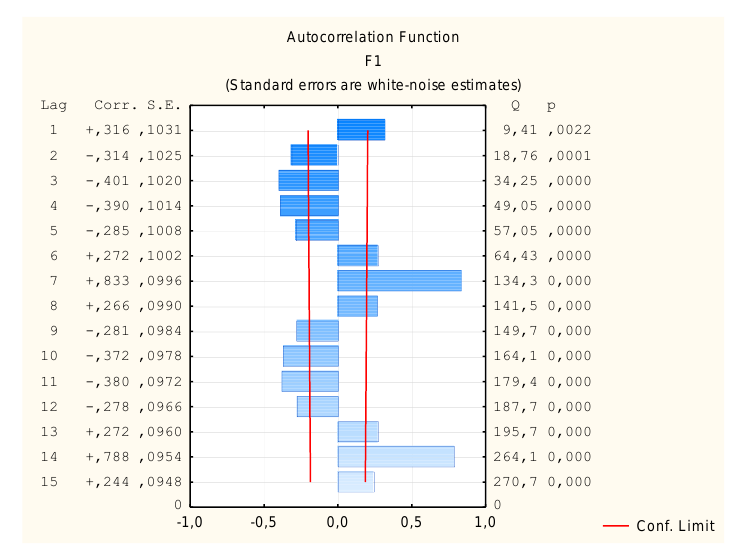
Fig. 10. Autocorrelation function of the 1-st